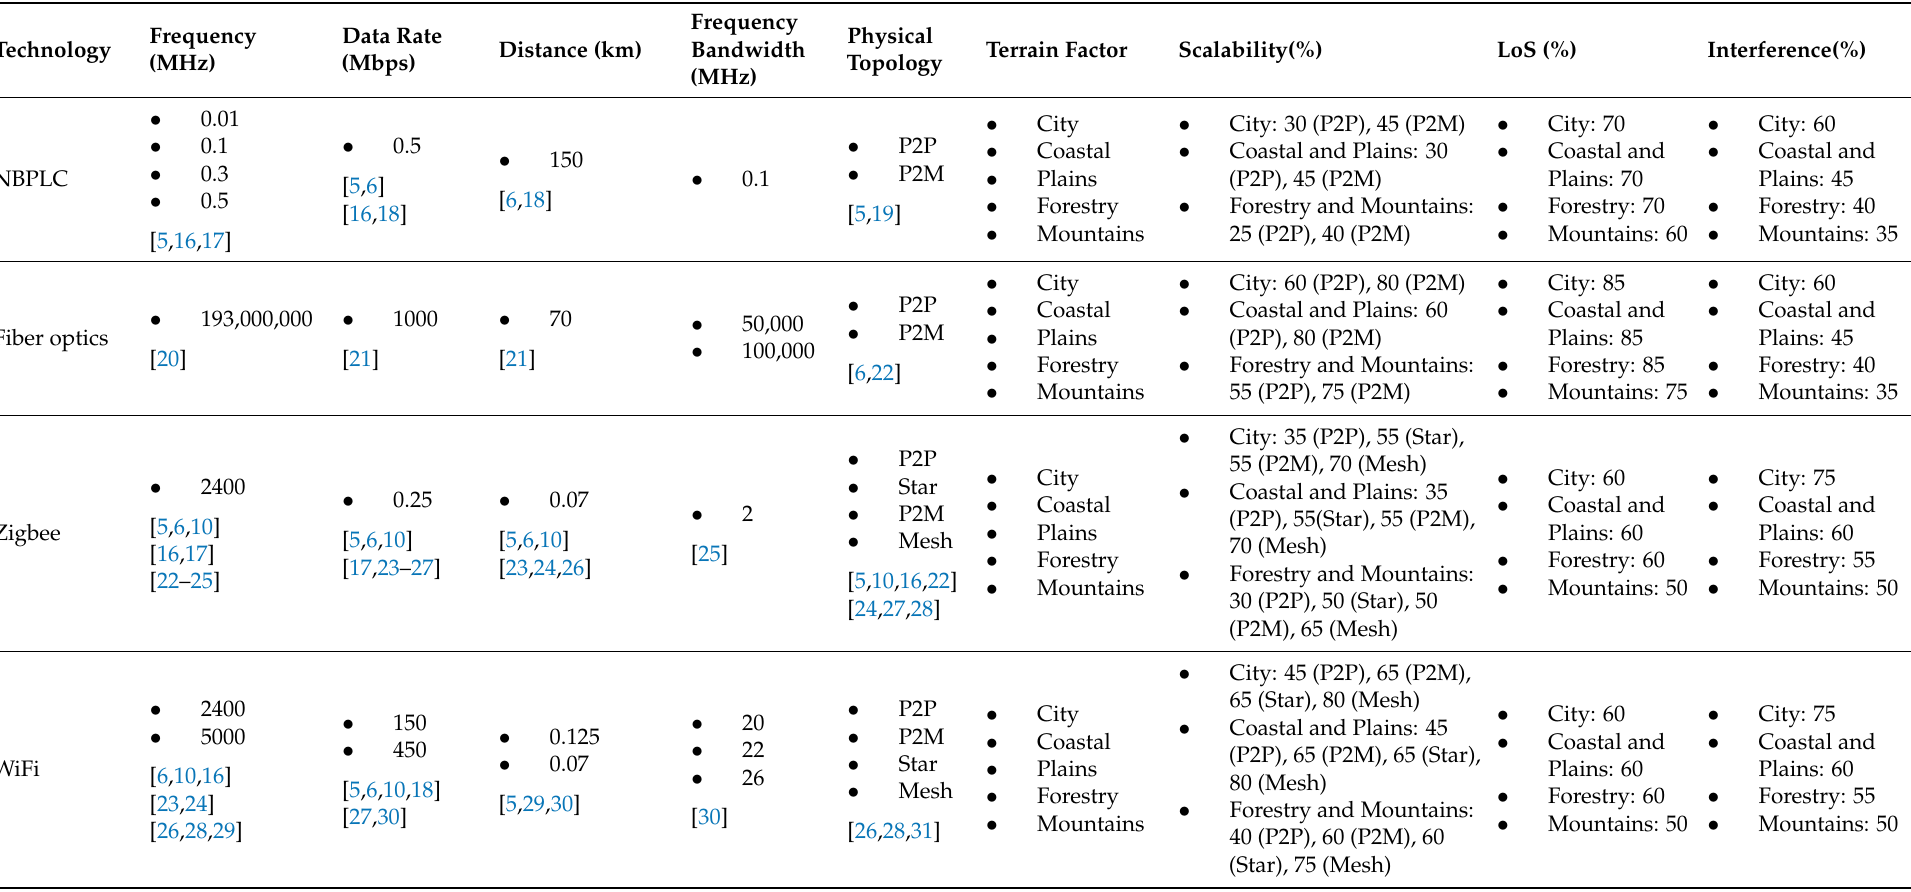
Table 3. The criteria specification of selected communication